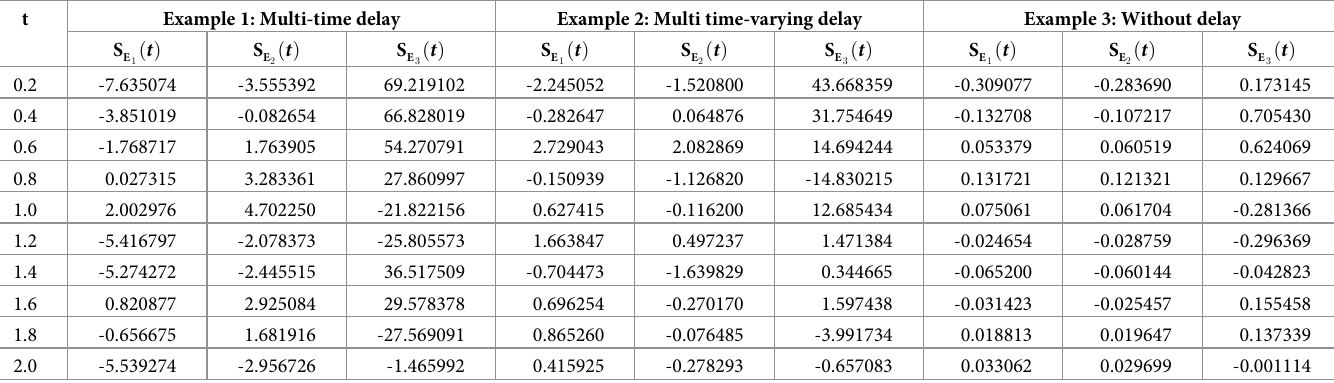
Table 2. Result for dynamic synchronization errors for the multi-time delay, multi time-varying delay and without